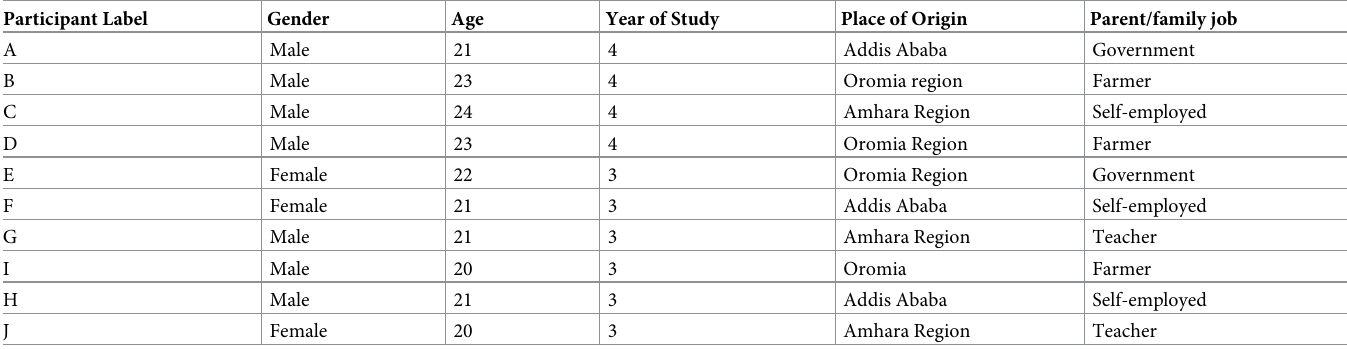
Table 1. The characteristics of the ten participants enrolled in this study. Participant